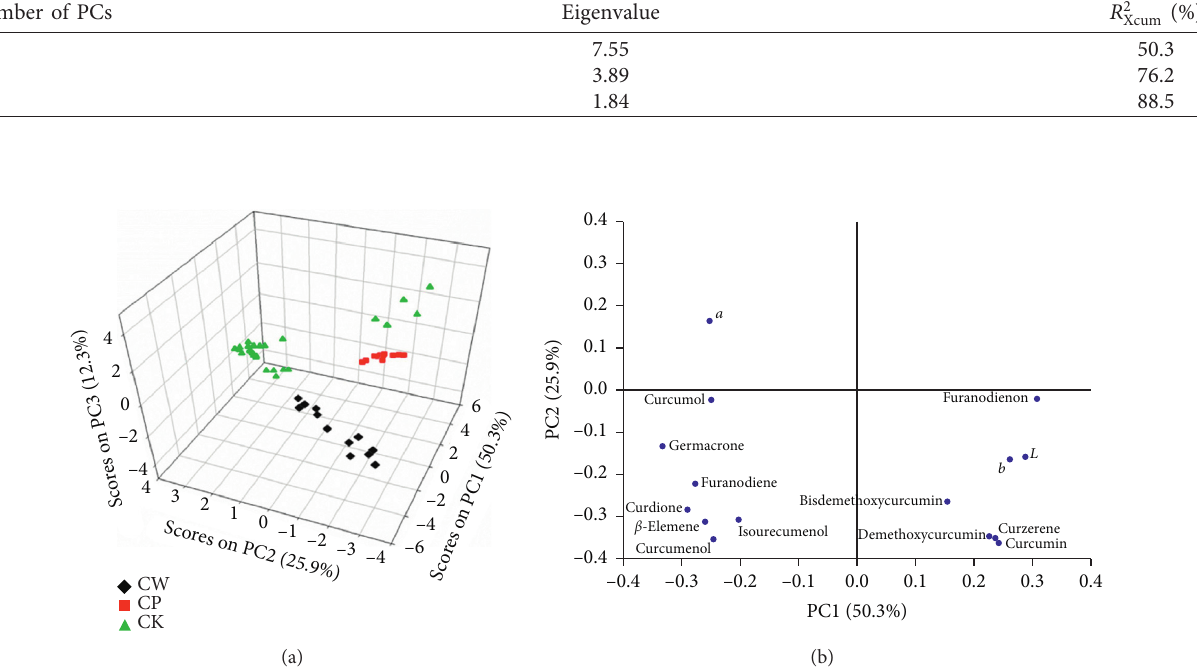
Figure 5: PCA model constructed on the data that combined the chemical ingredients and colour parameters for different species of Zedoray Rhizome samples. (a) Score plot. (b) Loading